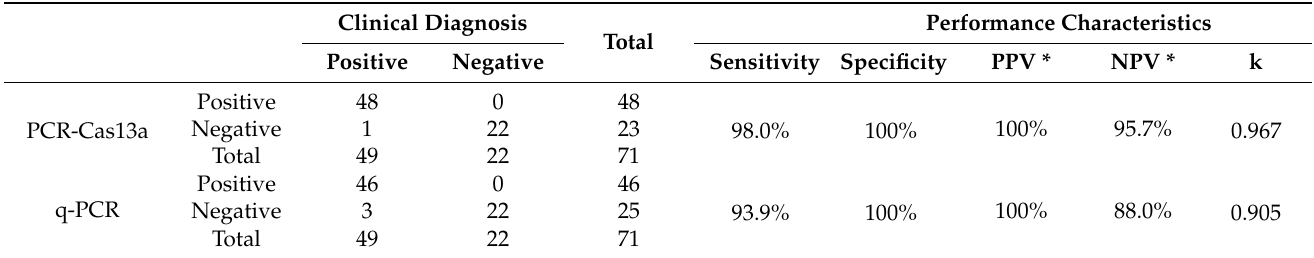
Table 2. Clinical samples consistency comparison between the two detection